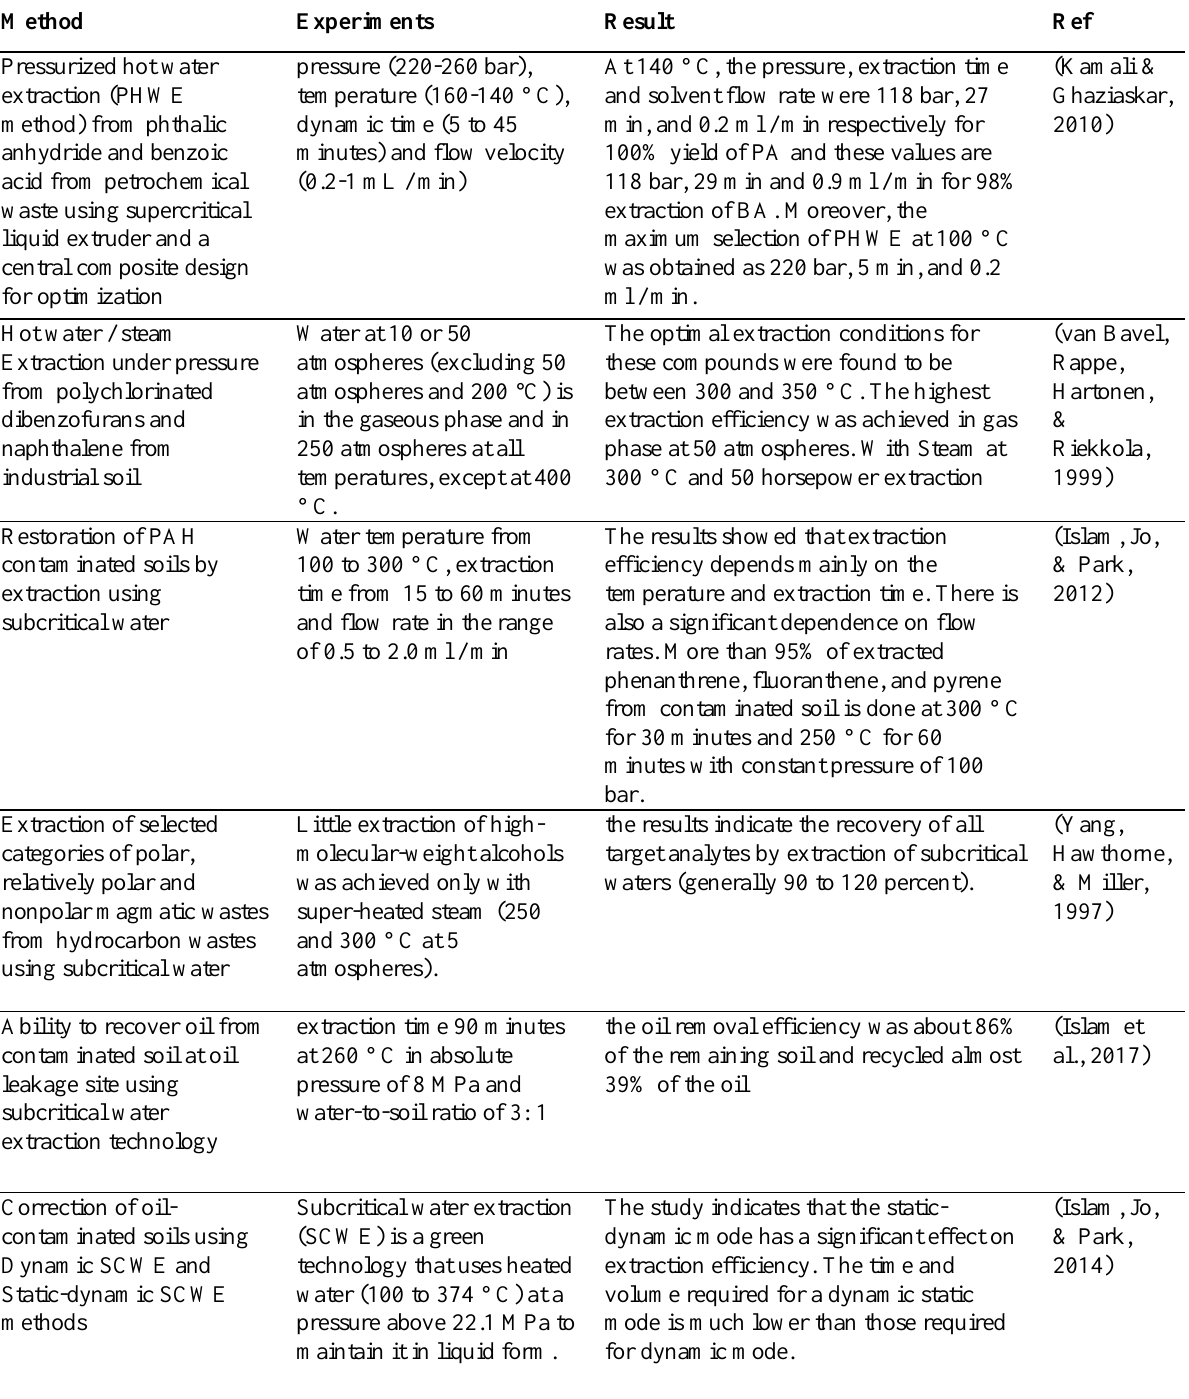
Table 2 . Summary of the methods used Processes using pressurized fluids for extraction of